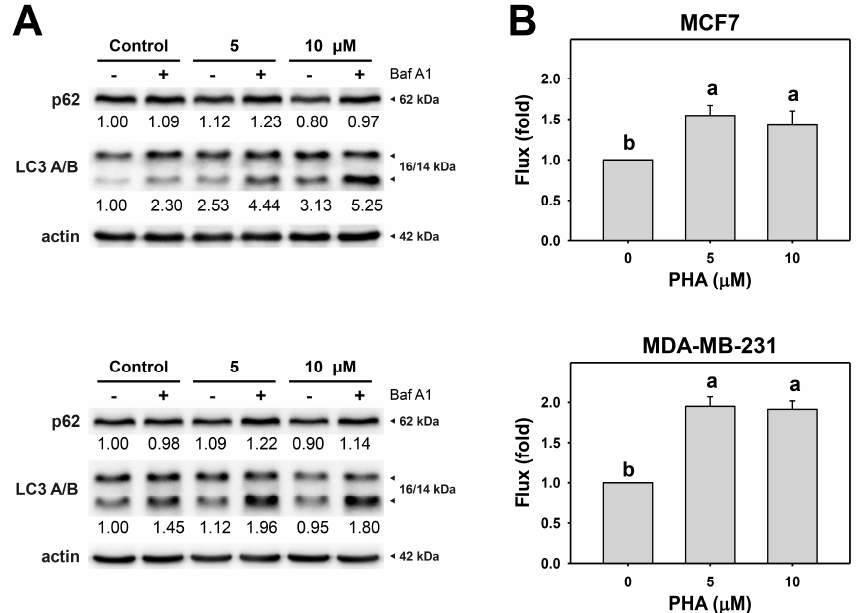
Figure 2. PHA induces autophagy and autophagic flux of breast cancer cells. ( A ) p62 and LC3 A/B expressions. ( B ) Autophagic flux. Cells were treated with PHA (0 (control), 5, and 10 μM) for 6 h and then co-treated with Baf A1 (control and 100 nM) for 2 h. Data, means ± SDs ( n = 3). Data with non-overlapping lower-case letters differ significantly ( p < 0.001 to 0.0001).